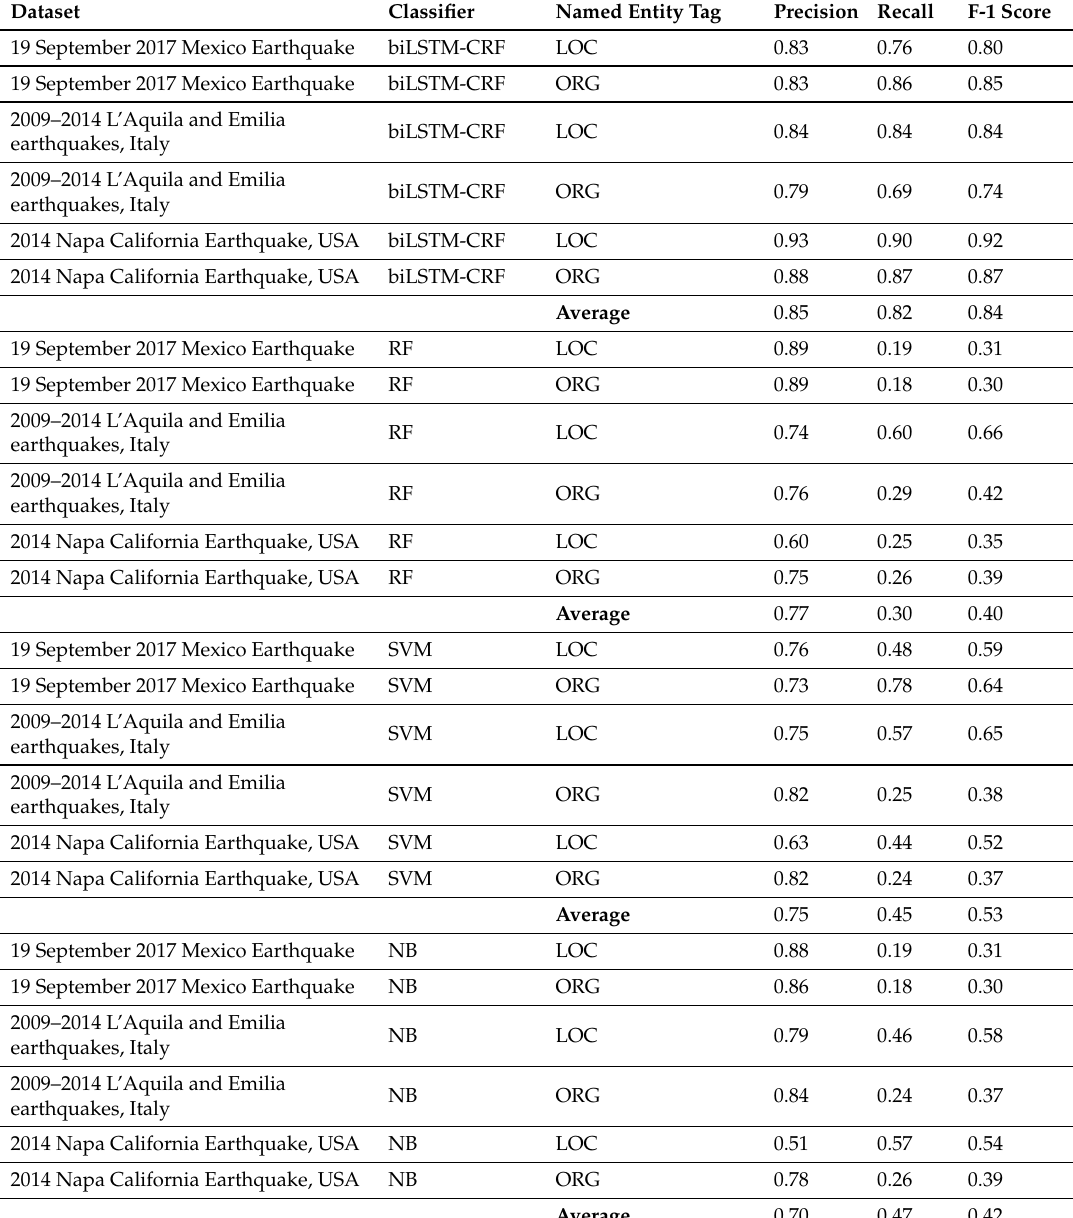
Table 7. Results